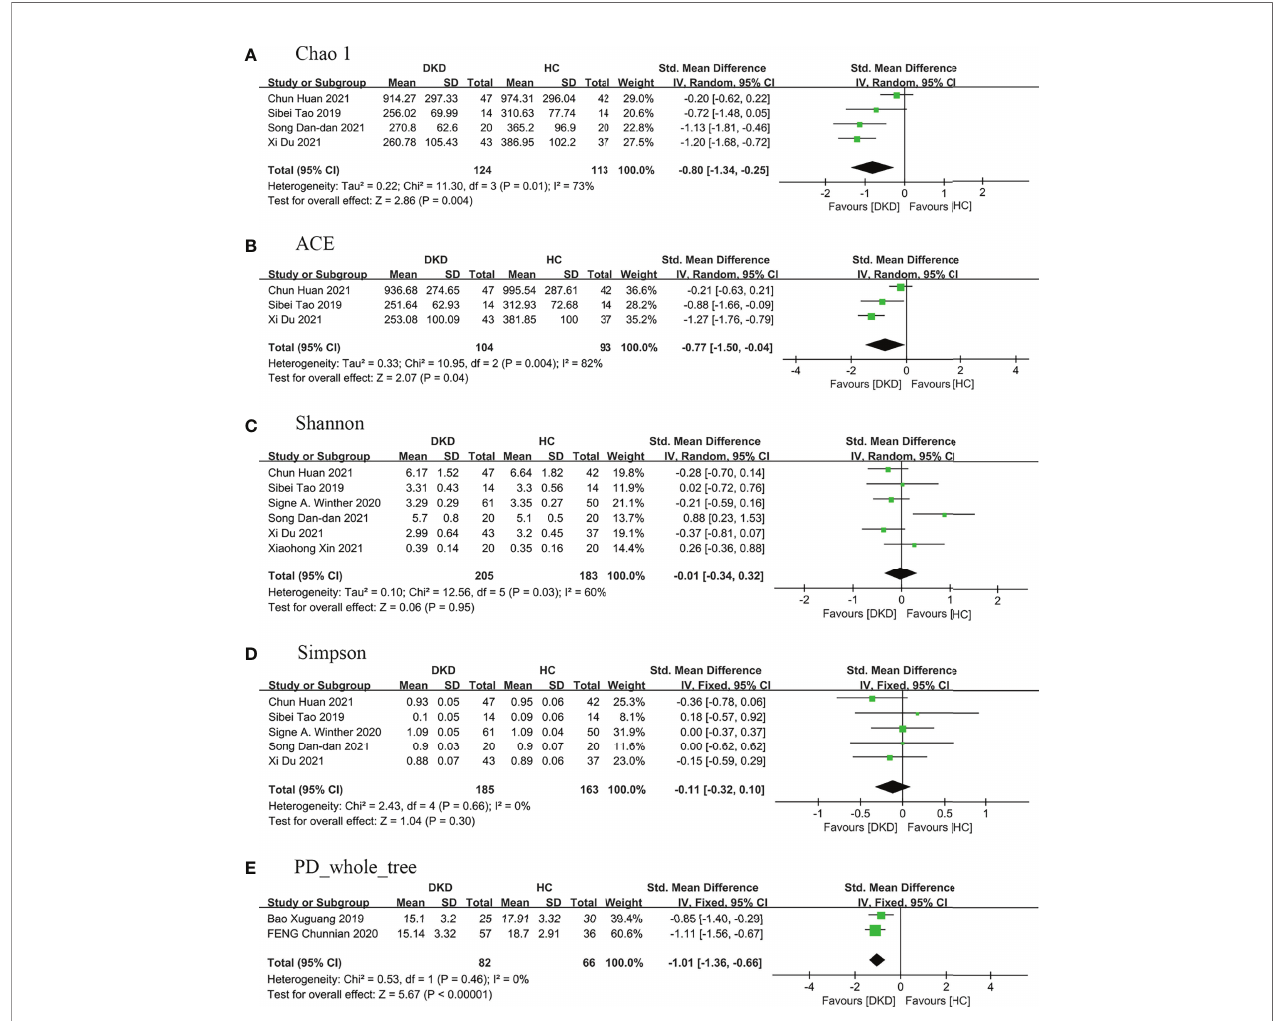
FIGURE 2 | Forest plots of alpha diversity in the gut microbiota of patients with DKD compared with HC. (A) Chao1 index, (B) ACE index, (C) Shannon index, (D) Simpson index, (E) PD_whole_tree index. A and B represent richness, while C, D, and E represent evenness. PD_whole_tree, phylogenetic diversity whole tree. DKD, diabetic kidney diseases; HC, healthy